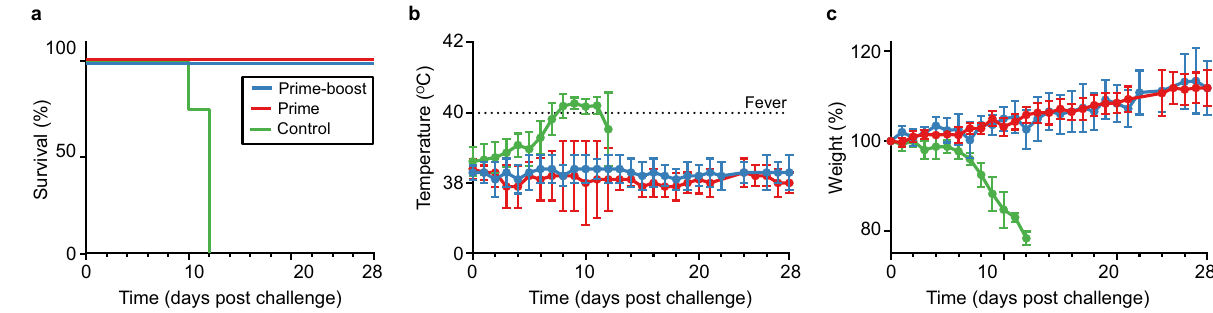
Fig. 4 ChAdOx1-Lassa-GPC-vaccinated guinea pigs are protected against lethal LASV challenge. a Survival of Hartley guinea pigs challenged with GPA LASV. Survival of vaccinated animals was signi fi cant compared to control animals by Mantel – Cox log-rank test (*** p = 0.0005). b Mean temperature of challenged animals; animals with a temperature of ≥ 40 °C were diagnosed as febrile. c Mean weight loss post LASV inoculation expressed as a percentage of animals ’ weight at the time of challenge (D0). Error bars represent the standard deviation of the mean for the survival cohort.